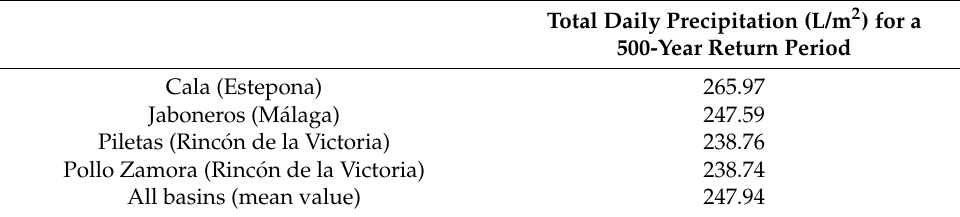
Table 1. Maximum daily precipitation for a 500-year return